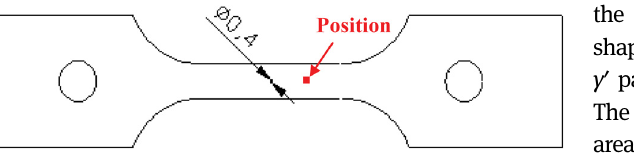
Figure 13: The position where the images are taken